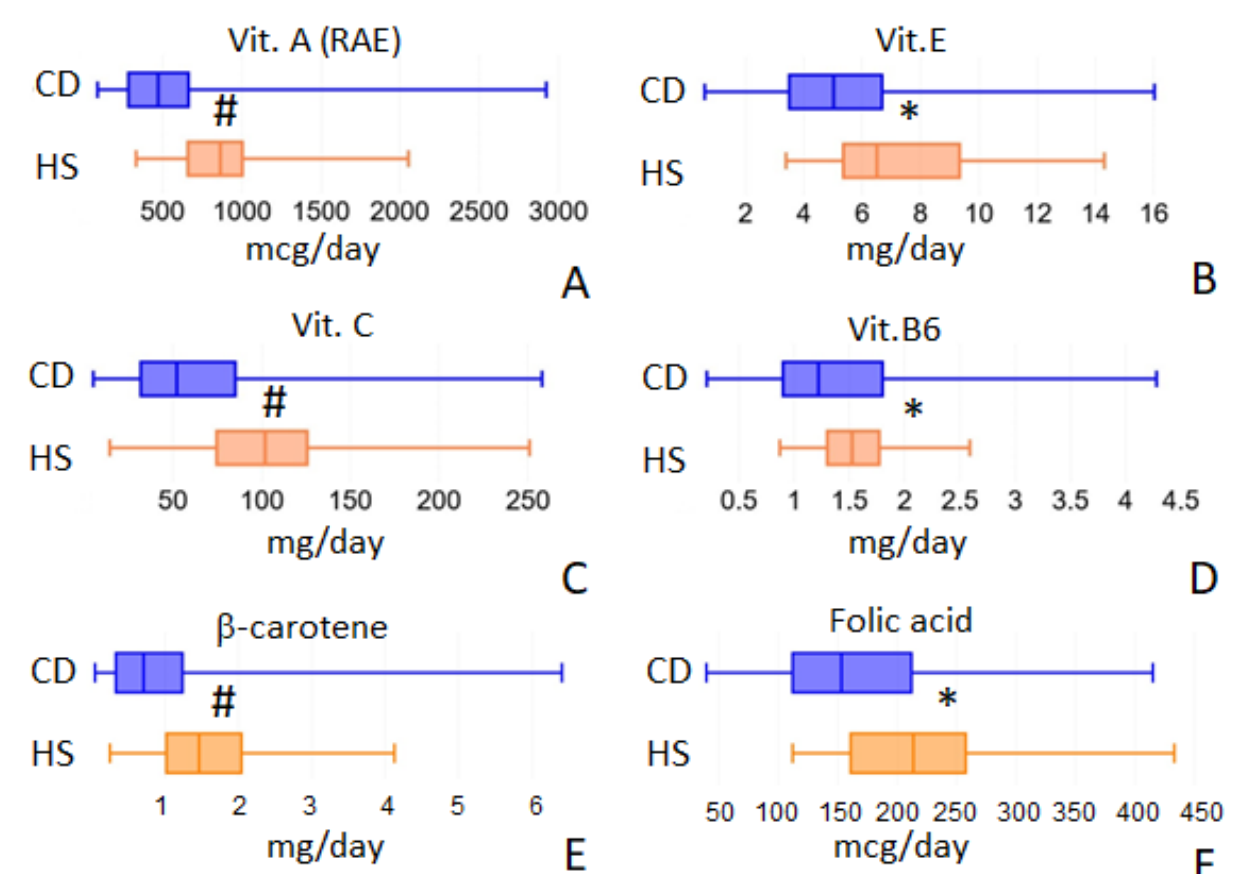
Figure 2. Vitamins intake values that showed differences between the two populations under study: vit. A (panel A ), vit. E (panel B ), vit. C (panel C ), vit. B6 (panel D ), β -carotene (panel E ) and folic acid (panel F ). * = p < 0.05; # = p < 0.01.